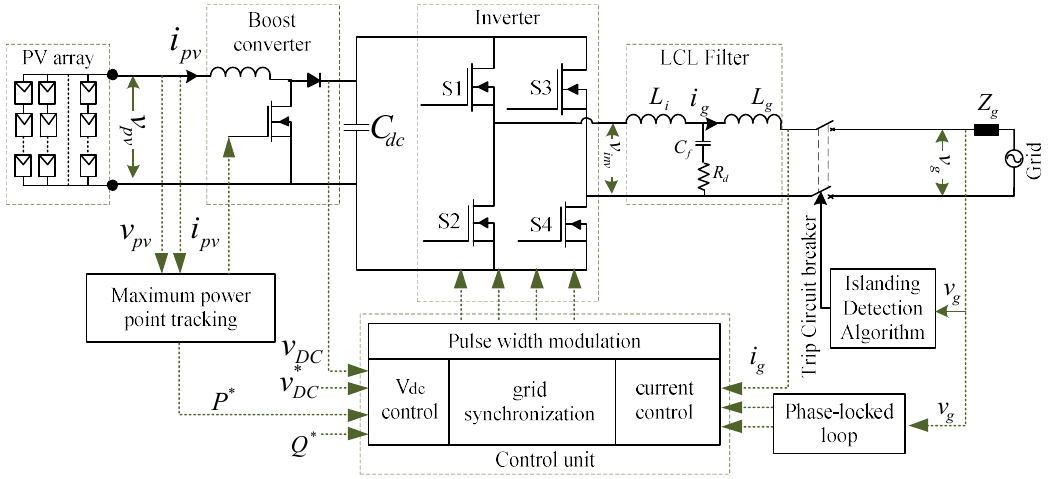
Figure 1. Outline of a single-phase grid-connected photovoltaic system.